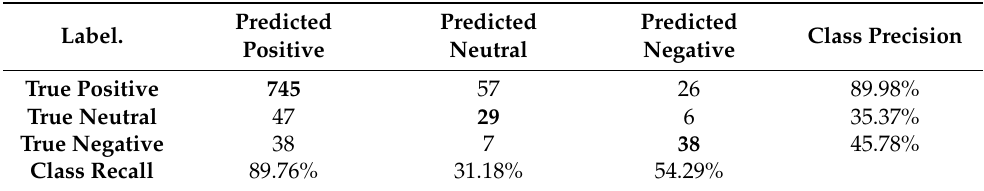
Table 5. Confusion matrix, which is the result of the Performance operator after applying the developed model to training or unlabeled dataset.